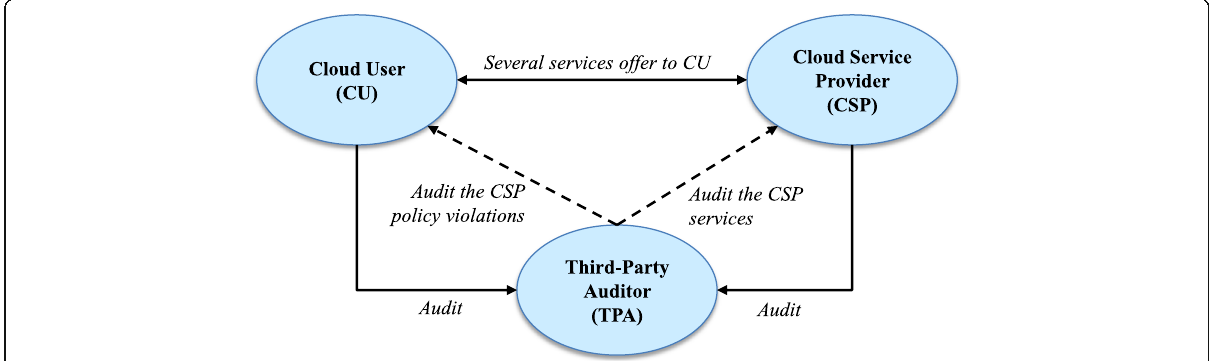
Fig. 2 A basic Cloud Computing Privacy-Preserving Authenticating